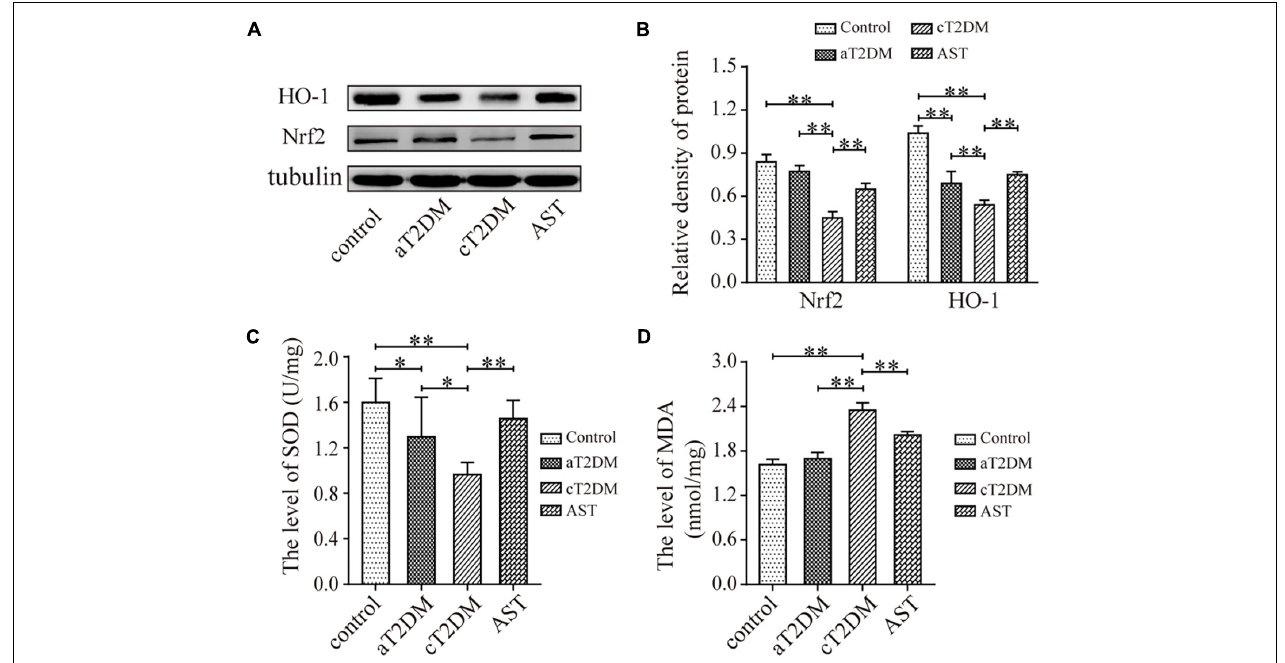
FIGURE 4 | The expression levels of Nrf2, HO-1, SOD, and MDA in each group. Representative protein bands of Nrf2 and HO-1 (A) ; Nrf2/tubulin and HO-1/tubulin ratio according to band density (B) ; The average level of SOD in each group ( C , units: U/mg); The average level of MDA in each group ( D , units: nmol/mg). Data are shown as the mean ± SD. ∗ P < 0.05, ∗∗ P < 0.01. aT2DM, acute type 2 diabetes mellitus; cT2DM, chronic type 2 diabetes mellitus; AST,